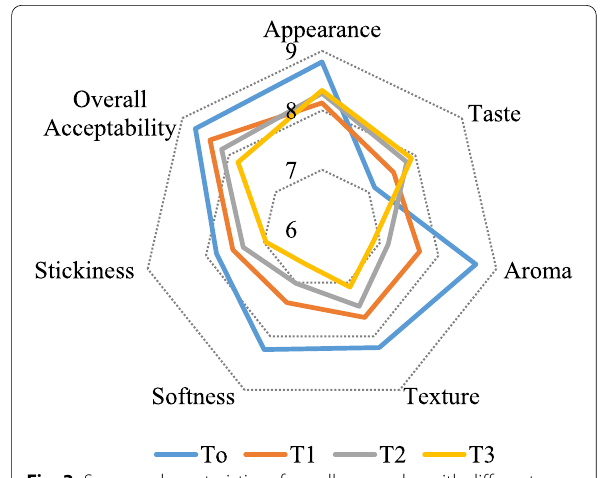
Fig. 3 Sensory characteristics of noodles samples with different levels (0, 5, 10 and 15%) of banana peel powder. Values are means score ( n 25). T 0 0% BPP 100% WF; T 1 5% BPP 95% = = + = T 2 10% BPP 90% WF; T 3 15% BPP 85% = + = +